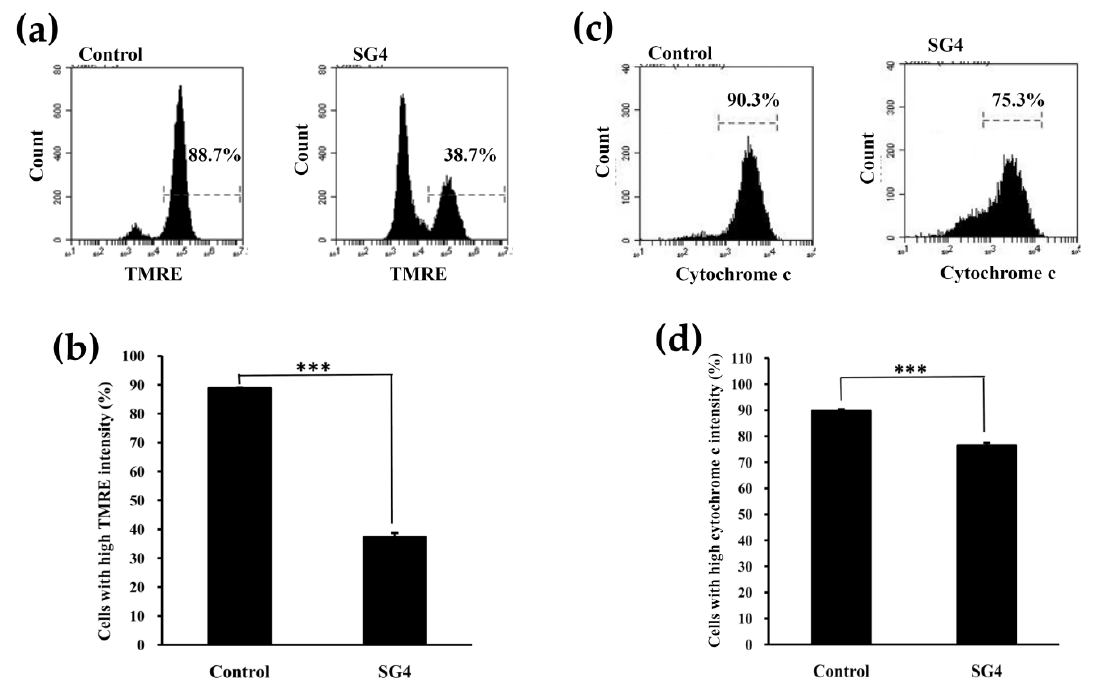
Figure 3. The MMP and cytochrome c analyses of HT-29 cells treated with 200 µg/mL SG4 for 48 h: ( a ) In the histograms, x axis and y axis denote TMRE content and cell counts, respectively. The percentage of cells with mean channel fluorescence values above the marker border is indicated in each histogram; ( b ) the percentage of cells with high fluorescence of TMRE is presented as determined for ( a ). ( c ) In the histograms, x axis and y axis denote cytochrome c content and cell counts, respectively. The percentage of cells with mean channel fluorescence values above the marker border is indicated in each histogram; ( d ) the percentage of cells with high fluorescence of cytochrome c is presented as determined for ( c ). The experiments were performed in triplicate. *** p < 0.001.